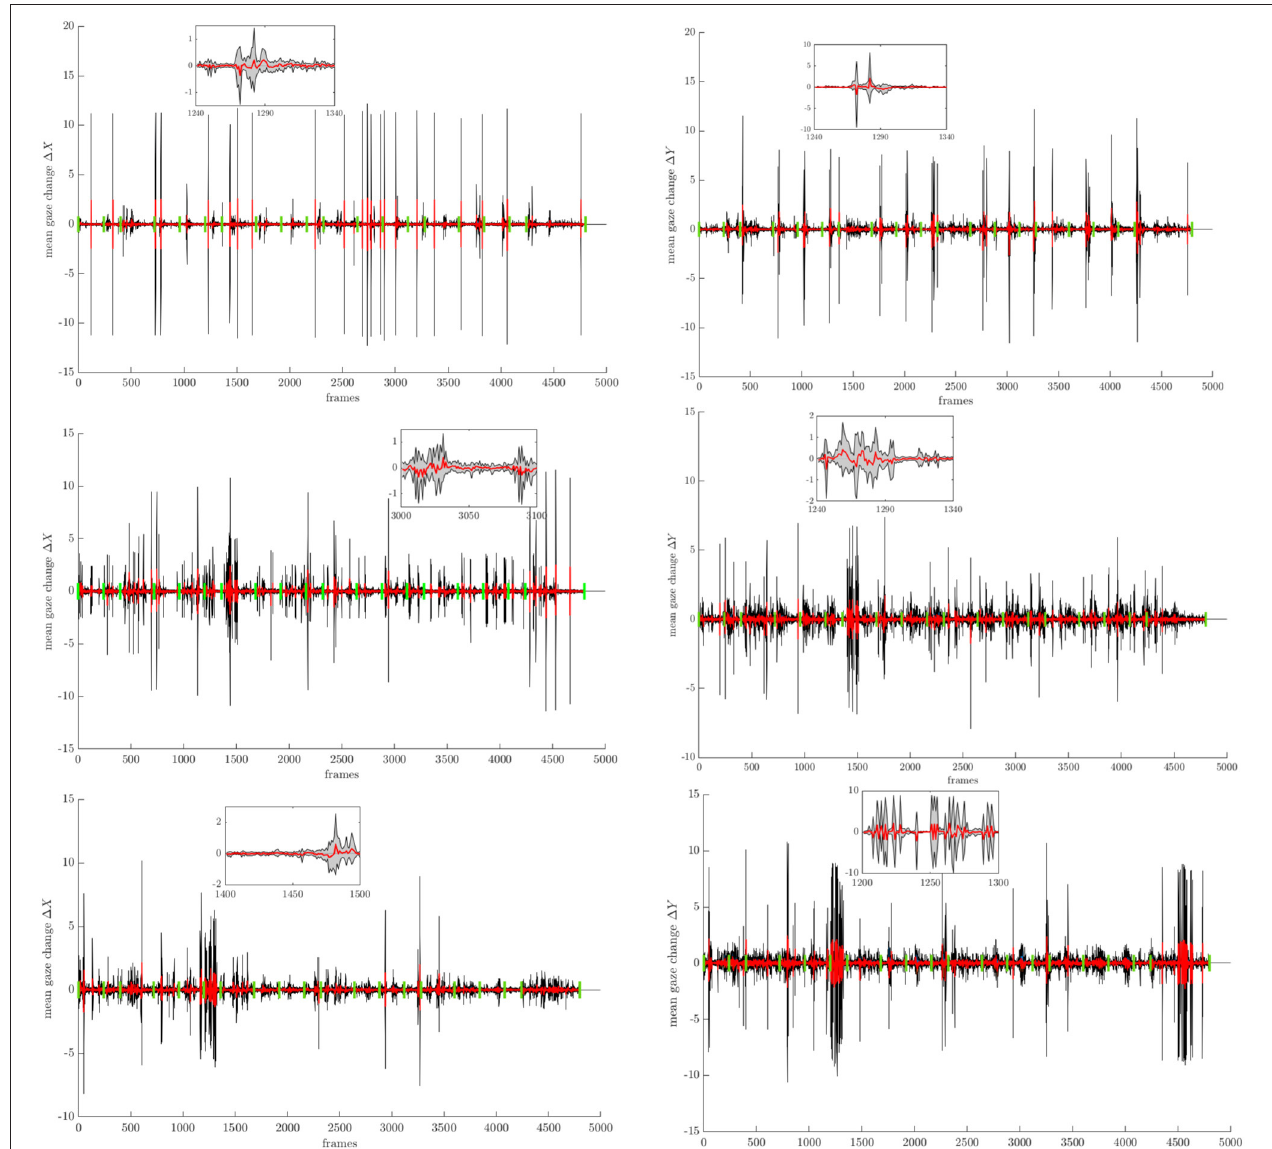
FIGURE 2 | Rate of change of the gaze angles in ◦ in { x } and { y } direction (pitch; yaw), averaged over all participants for the three conditions. The inset shows the filtered signal with the mean curve (red) and the standard deviation. The green vertical bars denote the task onsets (frame level).